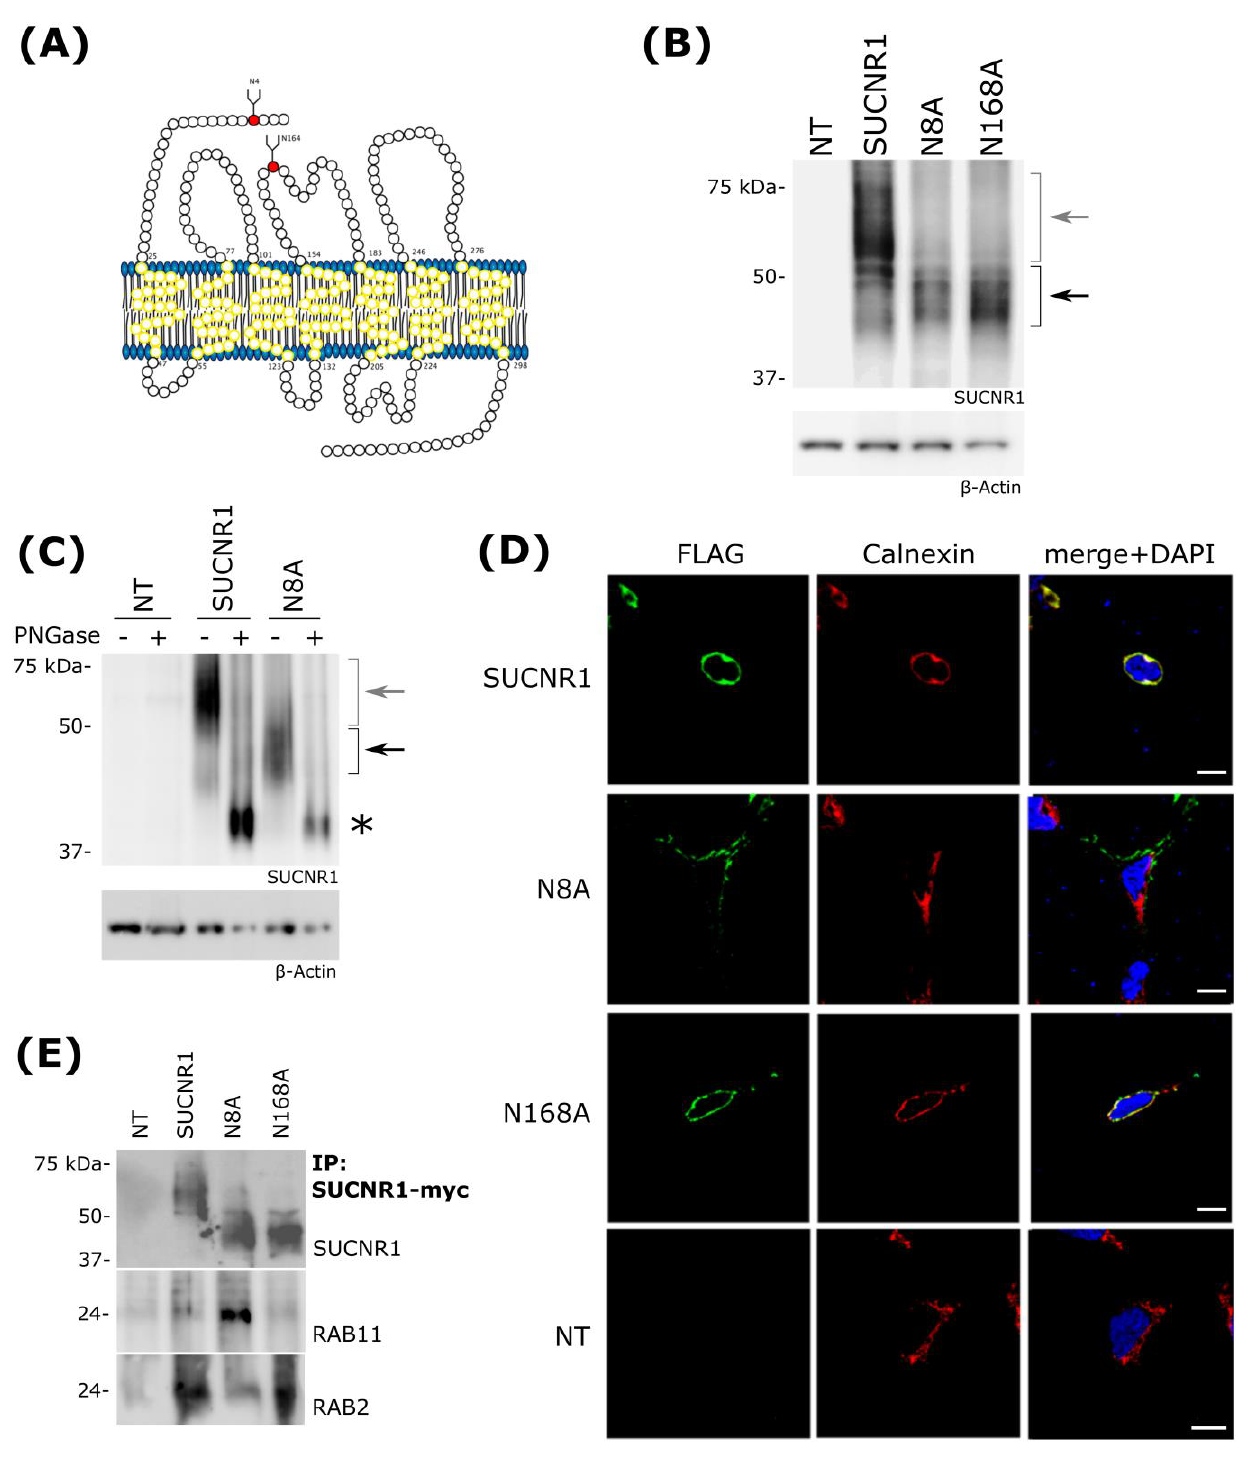
Figure 2. SUCNR1 N − glycosylation is necessary for ER retention. ( A ) Snake plot representation of theoretical mouse SUCNR1 topology, with potential N-glycosylation signals marked in red. ( B ) Steady-state levels of SUCNR1 and glycosylation-deficient mutants N8A and N168A in HEK 293T cells transfected with pcDNA-SUCNR1. Wild-type and mutant SUCNR1 proteins migrate as a smear characteristic of N-glycosylated proteins, albeit with a different molecular weight (wt and mutants indicated by grey and black arrows, respectively). ( C ) Transfected HEK 293T whole-cell lysates